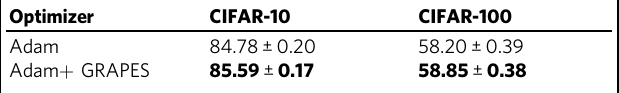
The network is a nine-layer residual architecture. The learning rate is decayed by 90% every 50 epochs and the initial learning rate is η = 1 e − 2. The models are trained for 250 epochs. The accuracy for each run is computed as the mean of the test accuracy over the last 10 training epochs. The reported result is the mean and standard deviation over the accuracy of ten independent runs. The bold font indicates the best performance for each